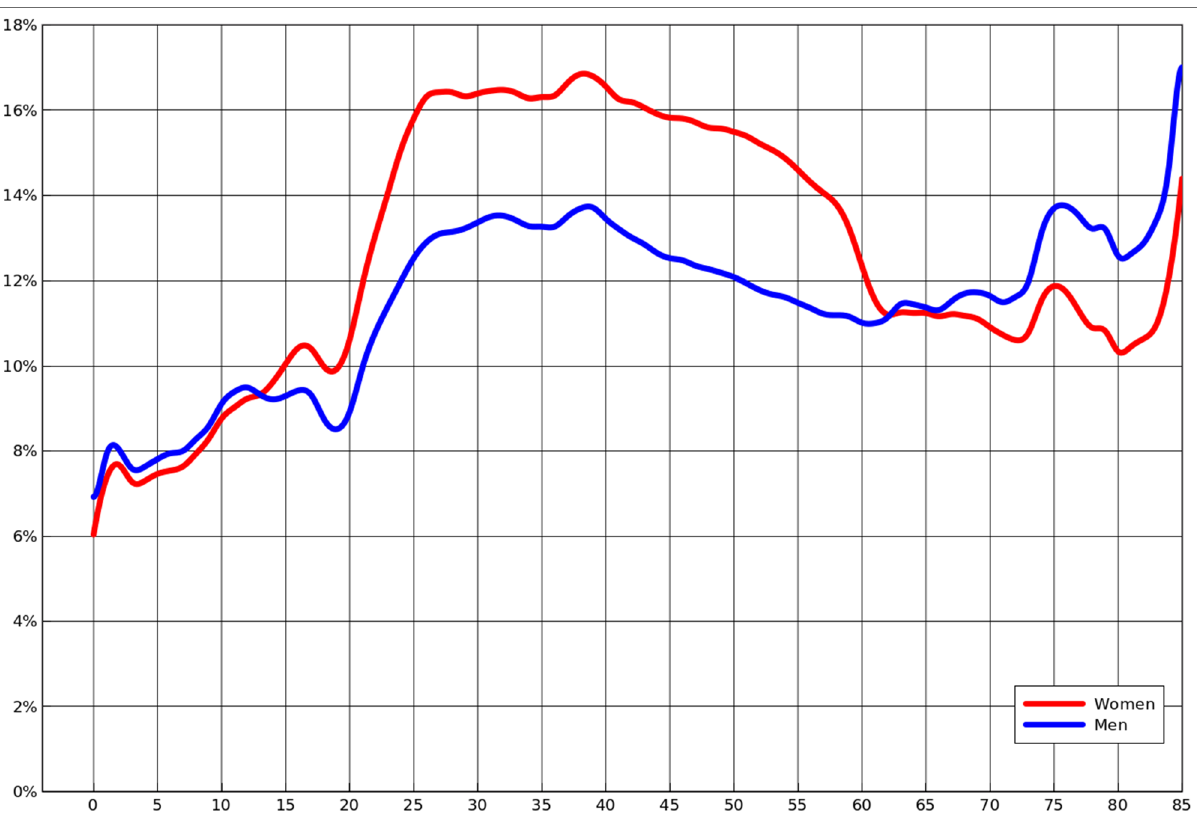
Figure 1. The percentage of each yearly cohort that was diagnosed with COVID-19, by gender, for the period 1 January 2021 to 21 March 2022. Due to data availability, values are smothered with 3 year moving average. Age brackets of 85 and above are grouped under 85.